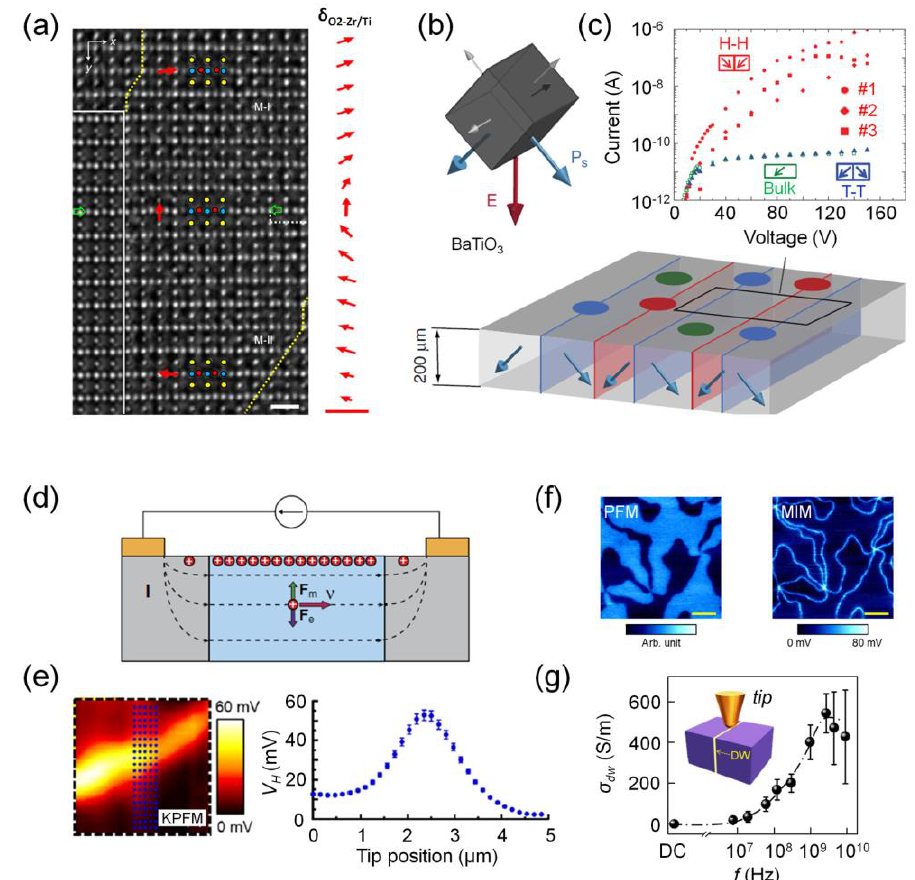
Figure 1. Non-Ising nature of walls ( a ): Atomically resolved transmission electron microscopy (TEM) image of the Neel-like continuous rotation of oxygen displacements across domain wall viewed along the [100] M direction. Green arrows denote domain wall. Scale bar shown in the TEM image is 0.5 nm. From the TEM image, the calculated evolution of the oxygen-displacement vector across the domain wall is shown on the right; scale bar, 30 pm [23]. Quasi 2 DEG (dimensional electron gas) at wall ( b , c ): A schematic showing electrical poling of a BaTiO 3 single crystal in the (110) c direction (red arrow) that allows two equally likely ferroelectric domain states (blue arrows) out of the six permitted (blue and grey arrows) ( b ). With this poling, tail-to-tail (T-T) and head-to-head (H-H) domain walls with periods ranging from 100 to 300 mm are formed in a 200 mm thick (110) c sample. I-V characteristics for bulk, H–H, and T-T domain walls ( c ) [28]. Hall measurements ( d , e ): Schematic of Hall e ff ect measurements using SPM techniques ( d ) [57]. Spatially resolved map of hall voltage ( V H ) and its cross-section profile across a T-T domain wall in an ErMnO 3 single crystal ( e ) [58]. AC conduction at domain walls ( f , g ): Piezoresponse force microscopy (PFM) and sMIM (frequency 1 GHz) images acquired on (001) ErMnO 3 single crystal ( f ). Domain wall conductivity ( σ DW ) versus frequency data for (001) YMnO 3 ( g ). Inset in ( g ) shows sMIM tip measuring domain wall [59].